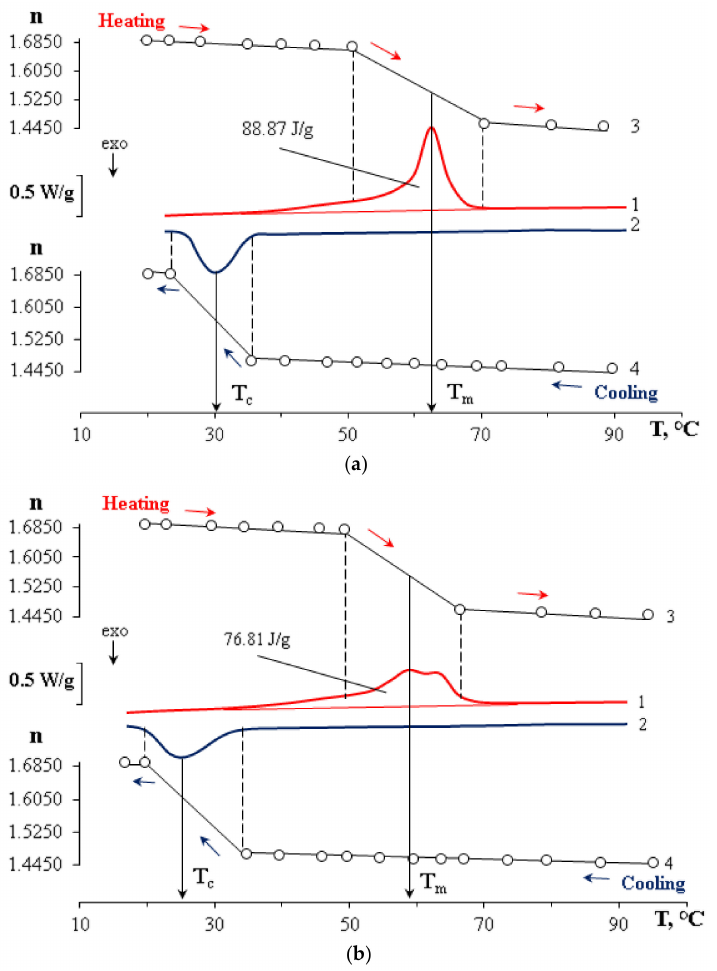
Figure 3. DSC thermograms in heating mode (1), cooling mode (2), and refractometric curves in heat- ing mode (3) and cooling mode (4) for PCL with ( a ) M n = 45 × 10 3 and PCL with ( b ) M n = 80 × 10 3 .